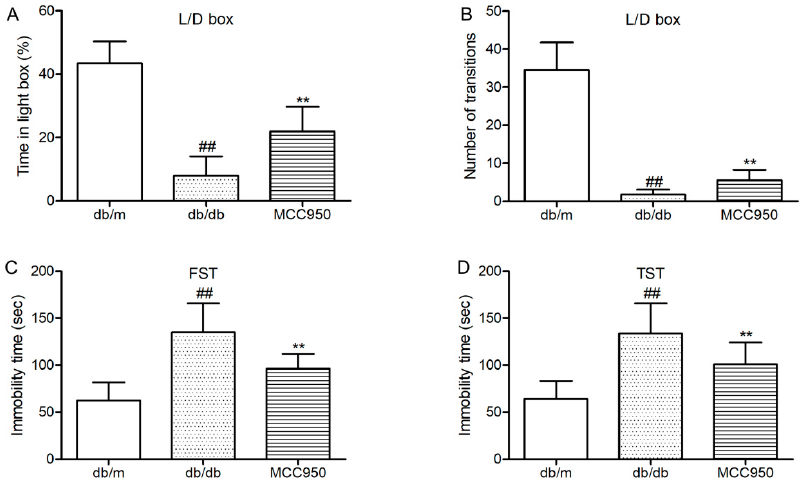
Figure 3. Effect of MCC950 on anxiety- and depression-like behaviors in db/db mice. ( A ) Percentage of time spent in lighted box of the light/dark (L/D) box; ( B ) Number of transition in the L/D box; ( C ) Immobility time in the forced swim test (FST); ( D ) Immobility time in the tail suspension test (TST). All data are represented as mean ± SD for eight mice in each group. ## p < 0.01, compared with the db/m-group; ** p < 0.01, compared with the db/db-group.